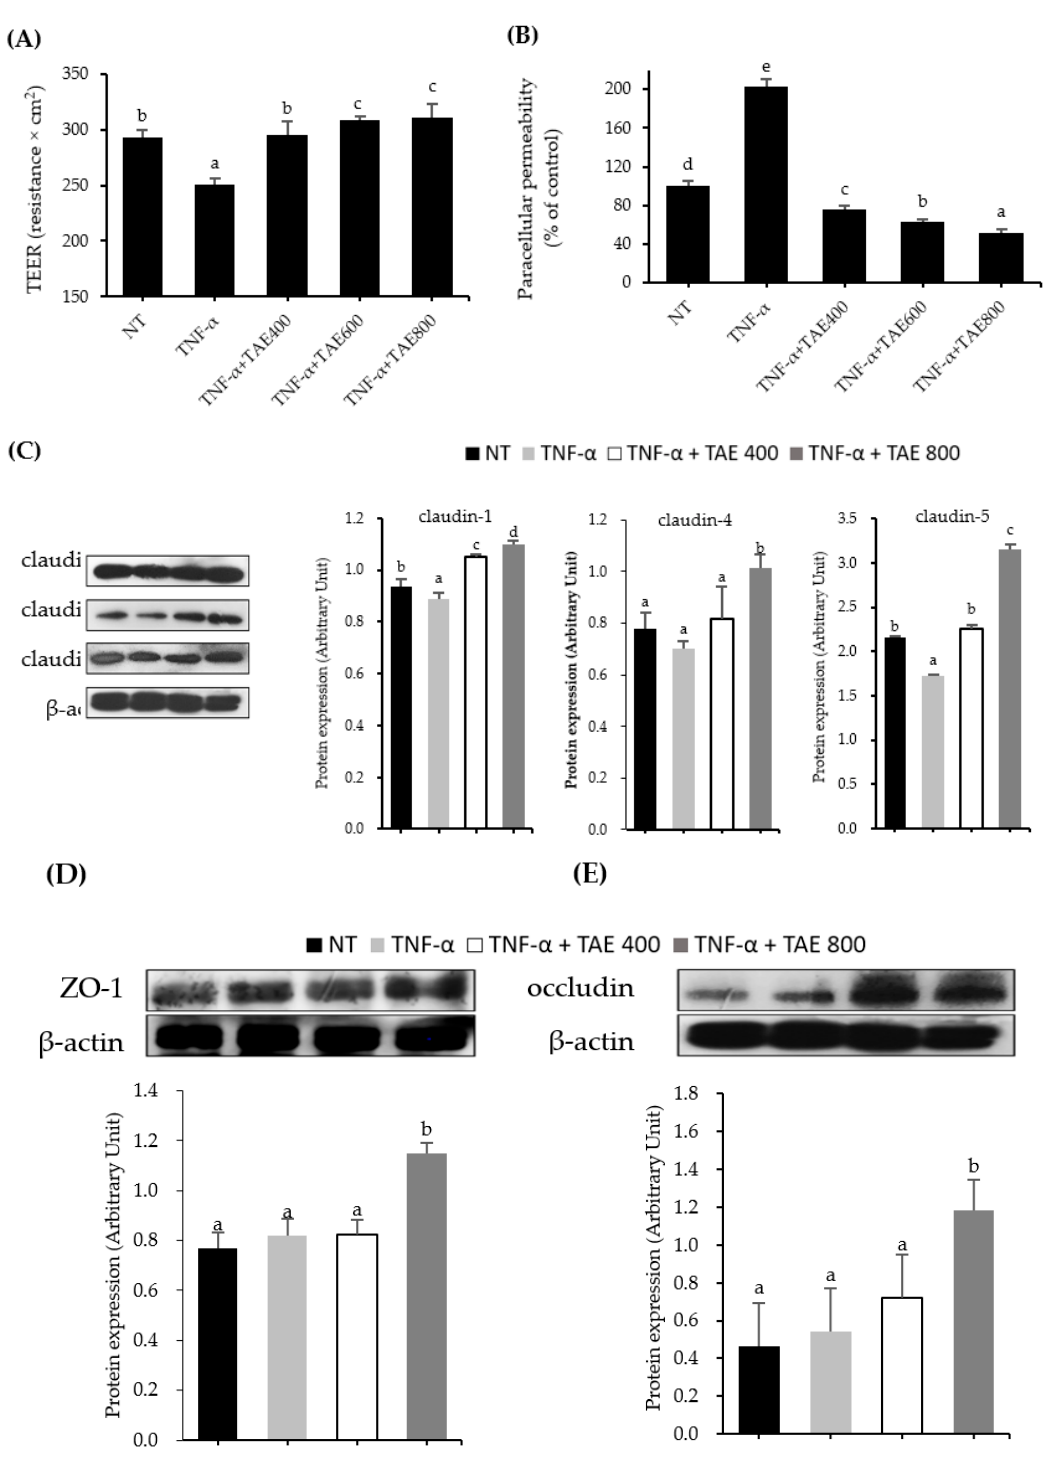
Figure 2. Preventive effects of thinned apple extract (TAE) on tumor necrosis factor-alpha (TNF- α ) reduced tight junction integrity in Caco-2 cells. ( A ) Transepithelial electrical resistance (TEER) and ( B ) paracellular permeability were measured in TNF- α -treated Caco-2 cells at 24 h incubation. The protective effect of TAE on the protein expression levels of ( C ) claudin-1, claudin-4, claudin-5, ( D ) ZO-1, and ( E ) occludin. Cells were treated with TAE for 1 h and then treated with 100 ng/mL of TNF- α for 24 h. Data are expressed as mean ± SD ( n = 6–9). Different letters indicate significant differences by Duncan’s multiple range test ( p < 0.05).